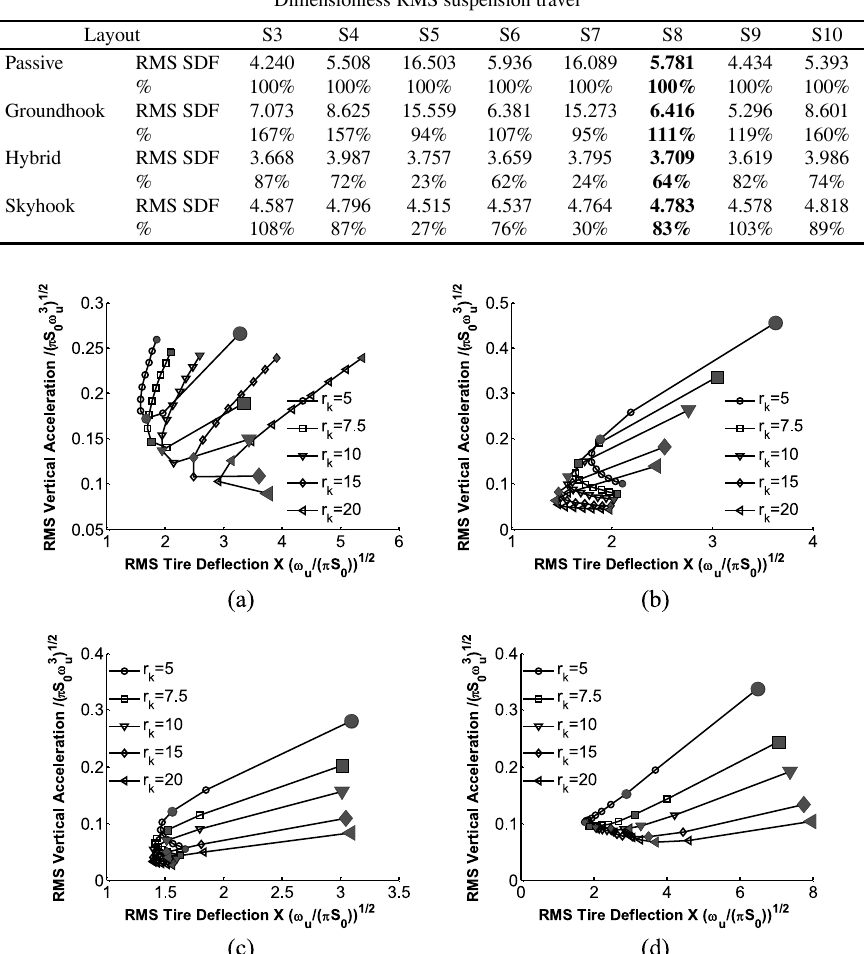
Fig. 5. Relationship between RMS acceleration and RMS tire de fl ection with layout s8 (effect of primary spring stiffness and damping): (a) Passive; (b) Groundhook; (c) Hybrid; (d) Skyhook. the unsprung mass from base excitations. The Skyhook control focuses on the sprung mass, as damping increases, the sprung mass motion decreases. With the Skyhook, the RMS sprung mass vertical acceleration decreased 30%, RMS suspension travel decreased 17% and RMS tire de fl ection increased 68%. The Hybrid con fi guration has the best compromise between comfort and road holding quality: the RMS sprung mass vertical acceleration